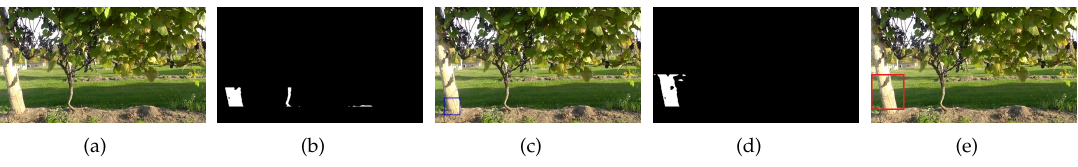
Figure 11. Robust pillar detection in vineyard (Pillar-1): ( a ) input RGB image; ( b ) binary image generated after noise removal from HSV image; ( c ) initial pillar detection in small search range; ( d ) binary image with pillar detection in enlarged search range; and ( e ) detected pillar.